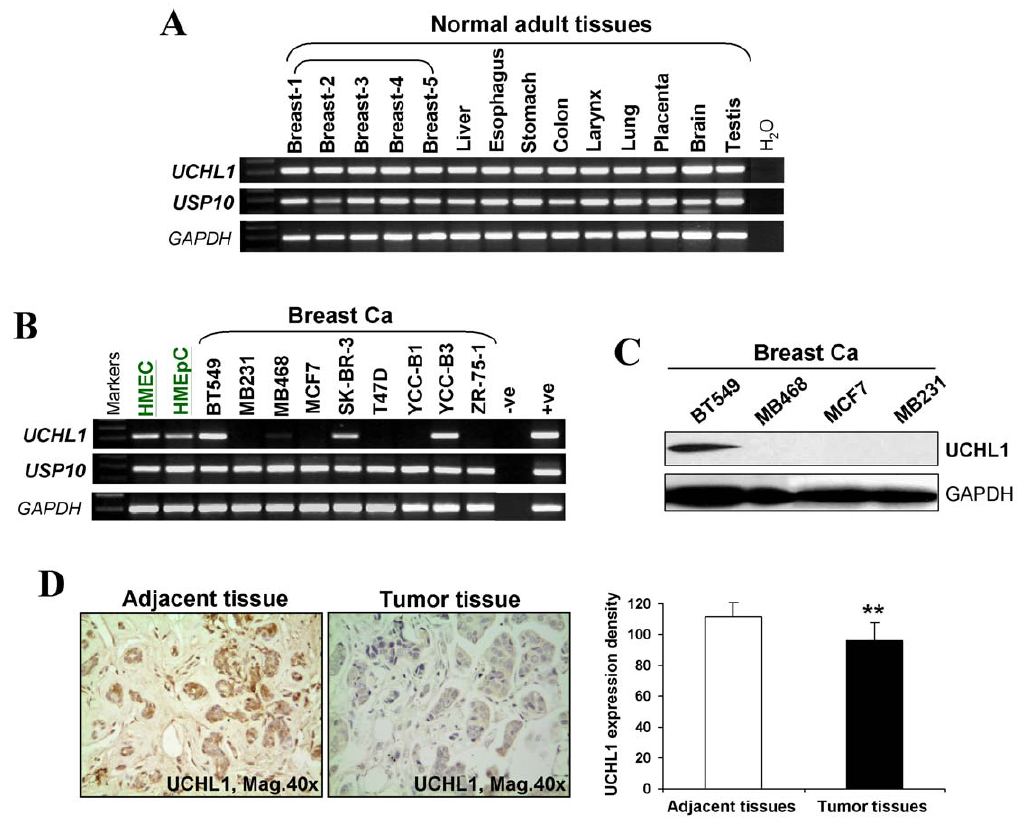
Figure 1. Downregulation of UCHL1 in breast cancer. (A and B) UCHL1 and USP10 expression in normal adult tissues (A), mammary epithelial cell lines and breast cancer cell lines (B), were evaluated using semi-quantitative RT-PCR, with GAPDH as a control. (C) UCHL1 protein expression was detected breast cancer cell lines by western blot. (D) Immunohistochemical analysis of UCHL1 in paired adjacent non-cancerous breast tissues and primary breast tumors.